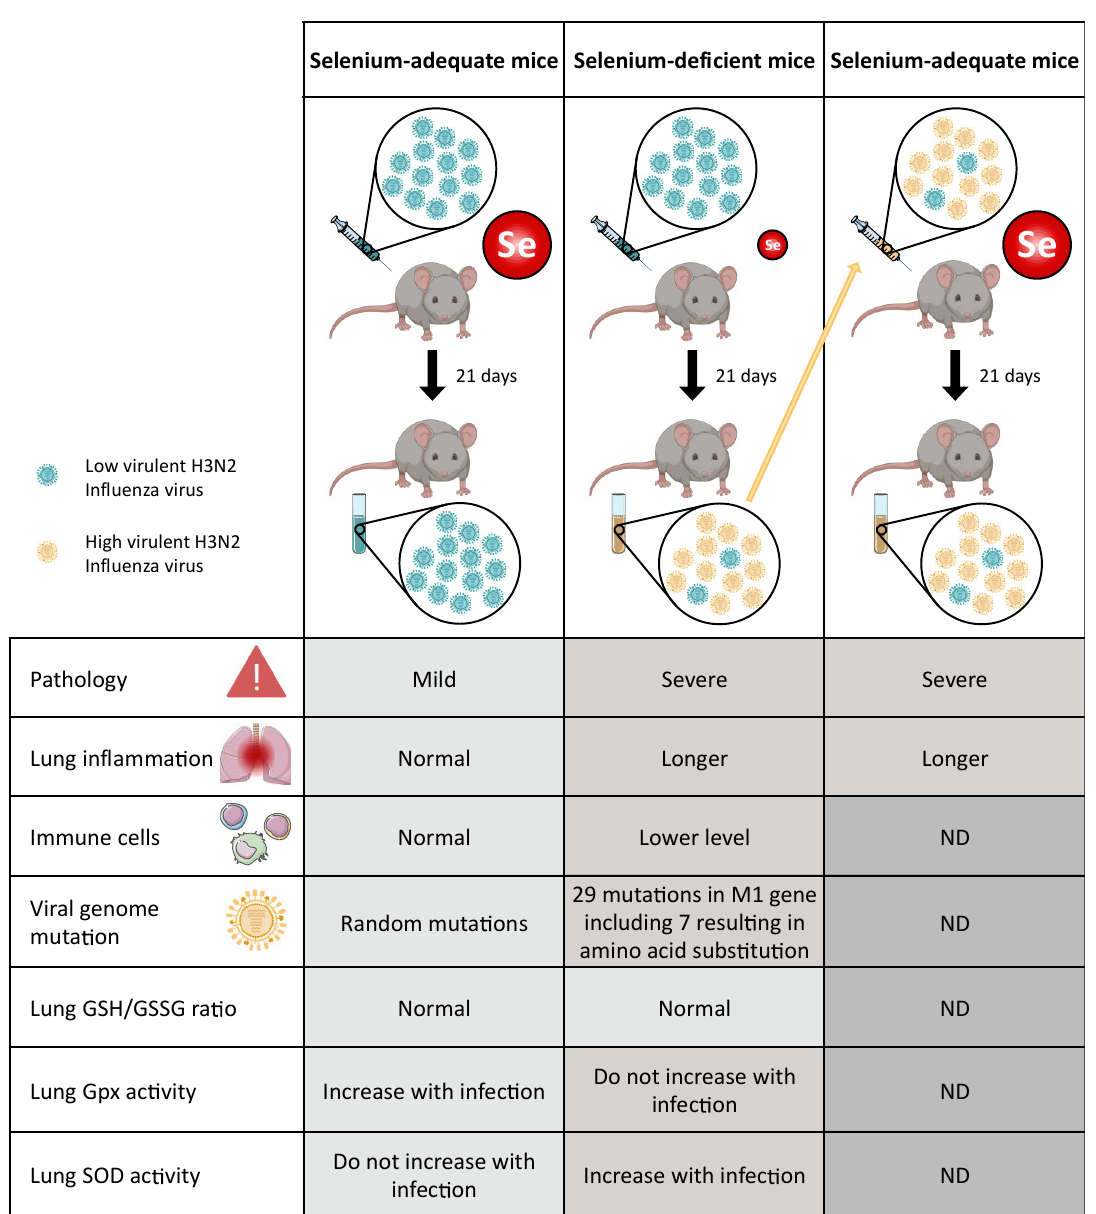
Figure 4. Evolution of the pathogenicity of influenza virus as a function of dietary selenium intake in mice. Influenza A / Bangkok / 1 / 79 (H3N2) virus was inoculated in mice that were previously fed with selenium adequate or deficient diet for four weeks. This virus induces mild pneumonitis in selenium-adequate mice but a severe lung pathology in selenium deficient mice [95,121–124]. Various parameters, including the time of lung inflammation, the number of immune cells, the nucleotide mutations of the isolated influenza viruses, the oxidation status of glutathione (reduced / oxidized), the GPX and SOD enzymatic activities in the lung, were evaluated and compared between selenium adequate (left column) and deficient (middle column) mice. The low and high virulent H3N2 viruses are represented in blue and yellow respectively. The virus recovered from selenium-deficient mice was inoculated in selenium-adequate mice to evaluate its pathogenicity. Consistent with the observations made with coxsackie virus, the mutations of the influenza viral genome increased the pathogenicity of the virus, which can now induce severe lung pathology even in selenium adequate mice [95,121–124].